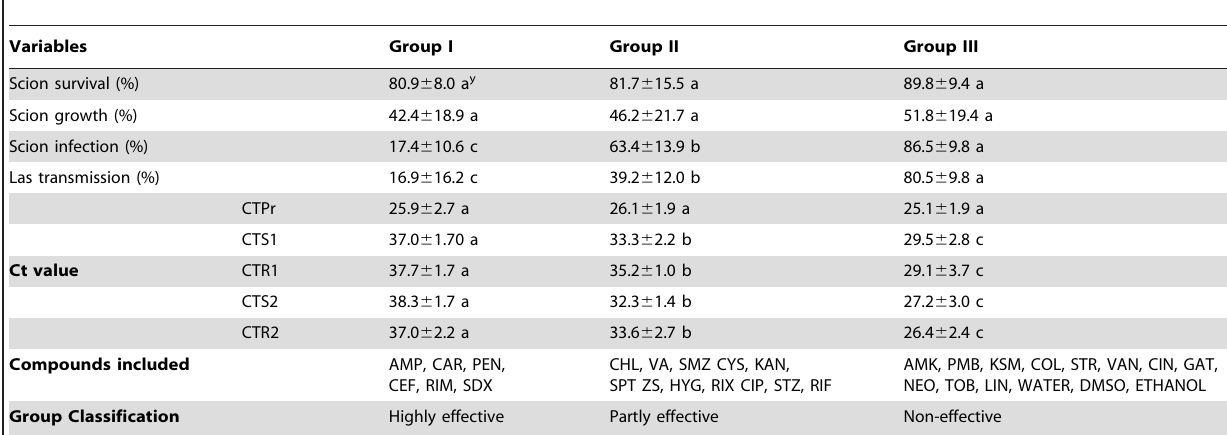
Table 3. Antibiotics classification of antibacterial activity against Las bacterium by hierarchical cluster